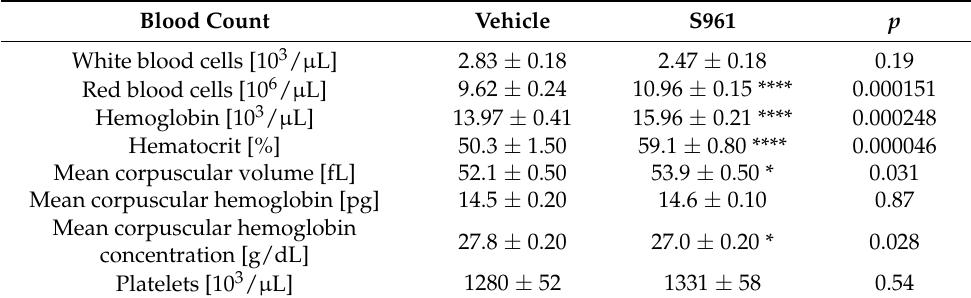
Table 2. Effect of S961 on blood count in mice after 2-weeks